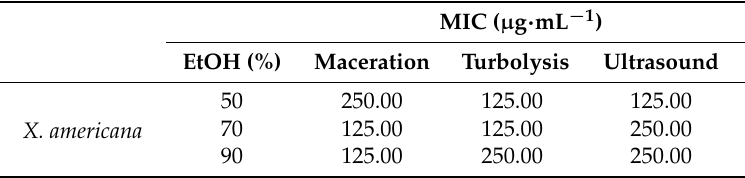
Table 1. Minimum Inhibitory Concentration (MIC) of extracts of X.